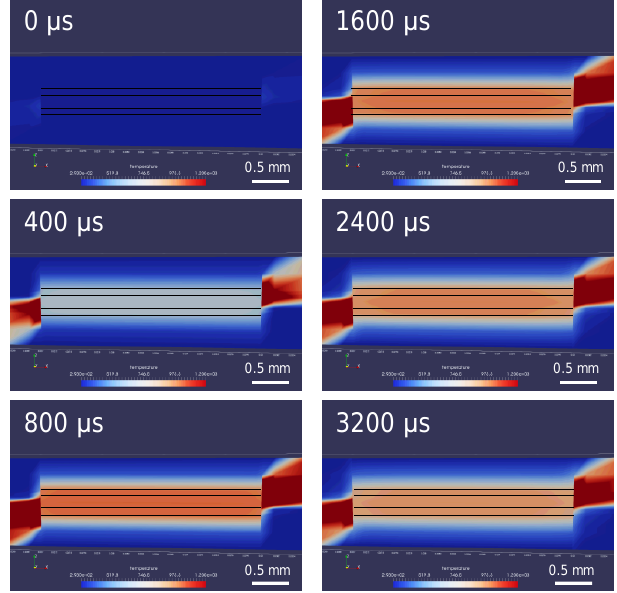
Figure 9. The faster heat dissipation at the interface is due to heat sinking in the BAl and Ti64.